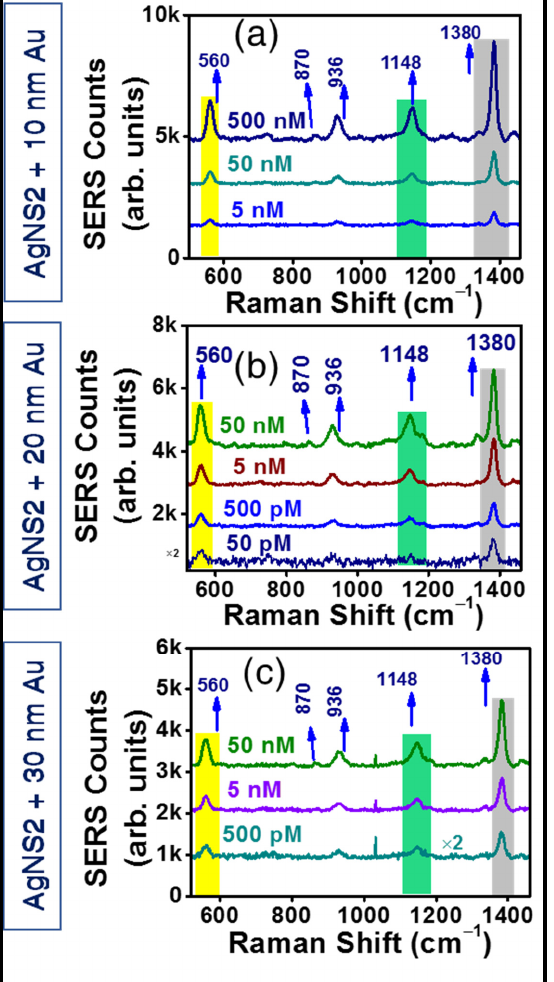
Figure 10. Concentration dependent SERS spectra of Au coated AgNS2 substrates in the detection of TH molecule. The lowest trace limits have been exhibited to be 5 nM from 10 nm coating ( a ), 50 pM from 20 nm coating ( b ), and 500 pM from 30 nm Au deposition ( c ). The best trace detection efficiency was achieved with 20 nm Au coated AgNS2. The reproducibility of the SERS signal was verified (data are presented in Supple-